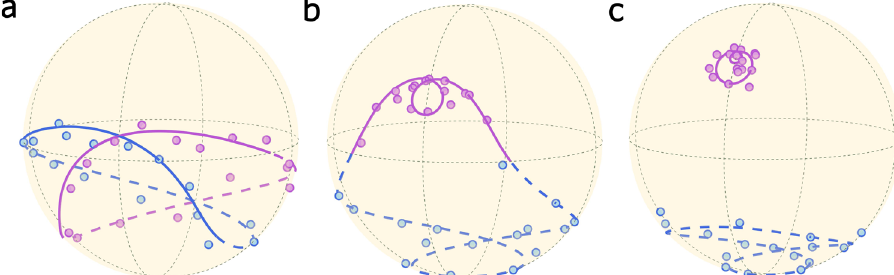
Fig. 5 Trajectories of the eigenvectors on the Bloch sphere. Parameters: a m 1 = 0.5338, m 2 = 0.6 (the Hopf link phase); b m 1 = 1.2730, = 0.6 (the unknot phase); and c m = 1.8889, m = 0.6 (the unlink phase). The purple and blue curves denote the theoretical trajectories of m 2 1 2 the two eigenvectors R 1 ð k Þj i and R 2 ð k Þj i as k sweeps from 0 to 2 π . The solid and dashed curves are achieved based on the evolution of H ( k ) and − H ( k ) respectively. The purple and blue dots represent the experimental results.